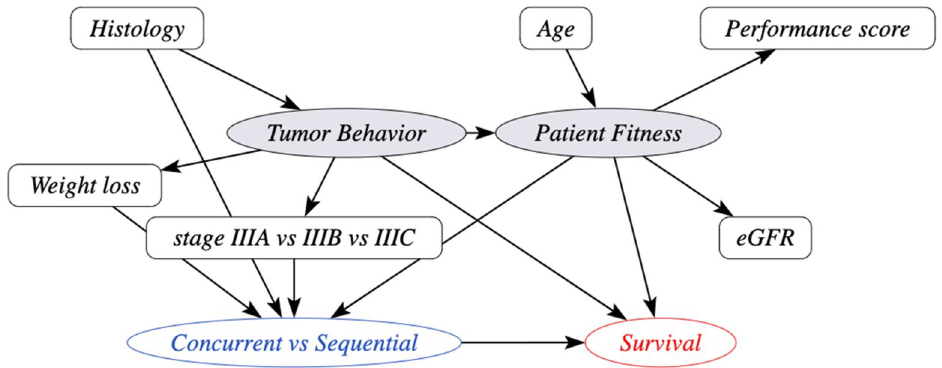
Figure 2. Causal Directed Acyclic Graph (DAG) with the variables involved in the treatment selection process and overall survival for stage III non-small cell lung cancer patients. Circles indicate variables, shaded variables are unobserved. Arrows point from a cause variable to an effect variable. This DAG is a direct extension of the behavior-fitness DAG scaffold from the PROTECT method in Fig. 1. PROTECT proxy based individual treatment effect modeling in cancer, eGFR estimated glomerular filtration